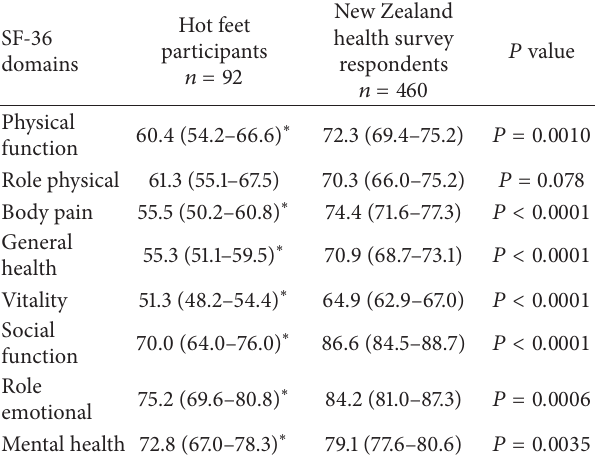
Table 2: The average and confidence interval of SF-36 Global Quality of Life Survey Scores of the self-identified study popula- tion compared to female New Zealand health survey respondents between the ages of 65–74 years.